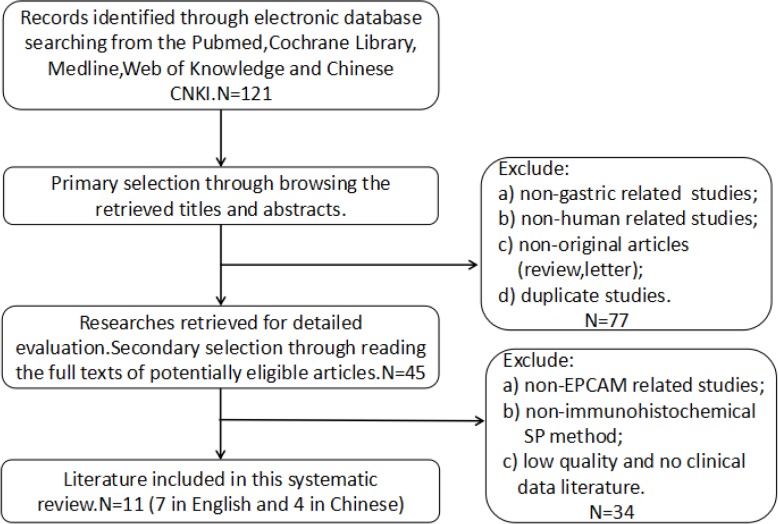
Flow chart for selection of the studies.